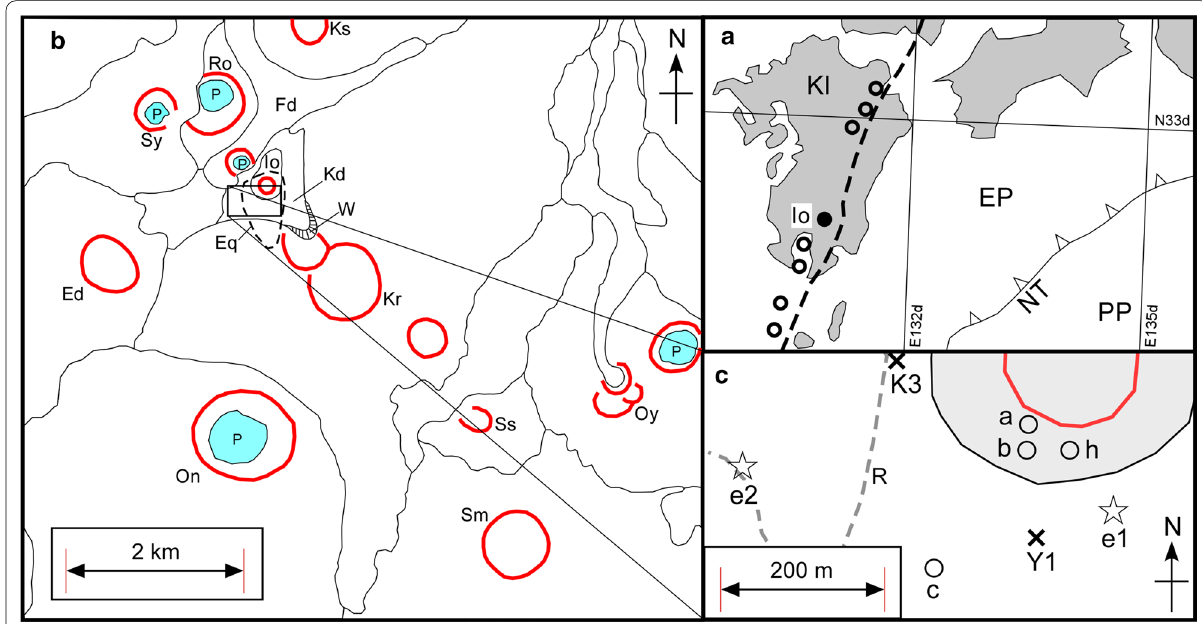
Fig. 1 a Location of Ebinokogen Ioyama volcano (Io) on Kyushu Island (KI), Japan. The Philippine Sea Plate (PP) is subducting beneath the Eurasian Plate (EP) on which KI is situated. PP and EP are separated by the Nankai trough (NT). Circles and broken line indicate active volcanoes and the volcanic front, respectively. b Io surrounded by Ebinodake volcano (Ed), Karakunidake volcano (Kr), Shiratori-yama crater (Sy), Rokkannonmiike crater (Ro), and Fudoike crater (Fd). Kd is a debris avalanche deposit. P and W denote ponds and collapse walls, respectively. Eq denotes the region in which the volcanic earthquake hypocenters are distributed. Sm, Ss, Oy, Ks and On denote Shinmoedake volcano, Shishidodake volcano, Ohatayama volcano, Koshikidake volcano and Onamiike volcano, respectively. Bold red curves indicate the crater rim. c Location of fumaroles a, b, c and h. Phreatic eruptions took place at e1 and e2 on April 16 and 26, 2018, respectively. Hot spring water was discharged at K3 and Y1. R denotes